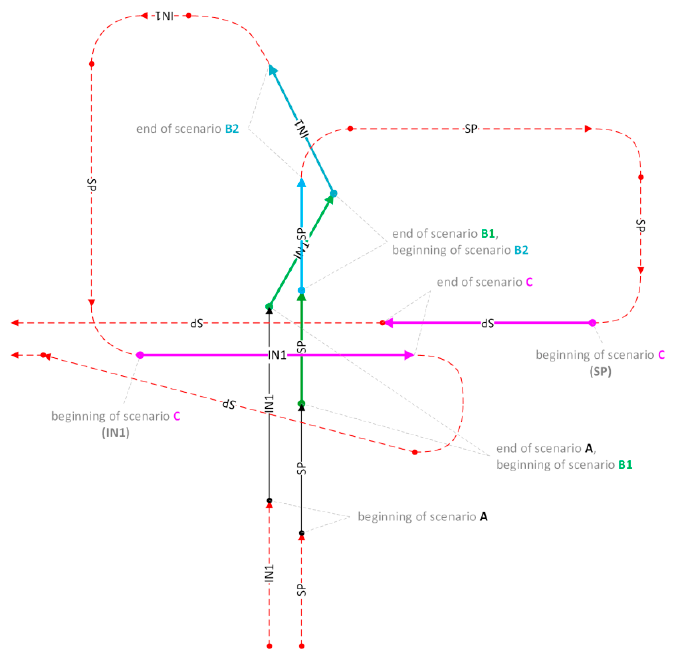
Figure 6. Graphical diagram of the flight plan for implementing CS-23/CS-25 class intruder detection scenarios; IN1—intruder number 1, SP—IDAAS equipped airplane.